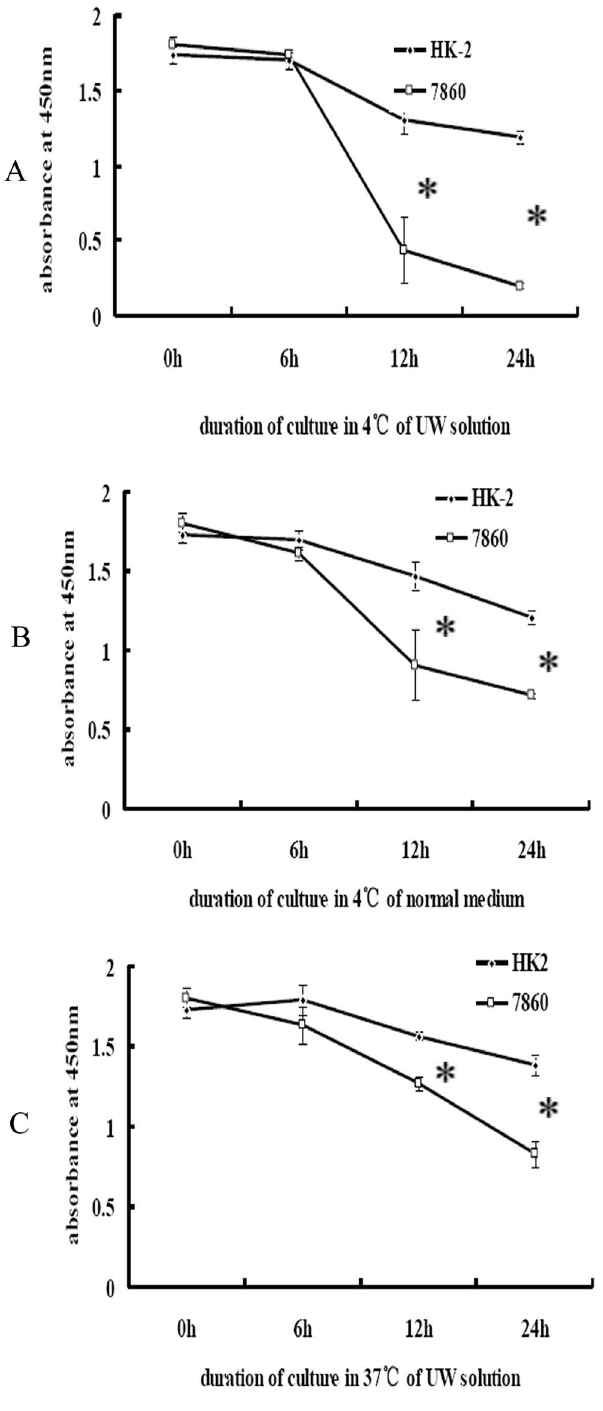
Figure 1. Cellular proliferation under various experimental conditions. Proliferation of HK-2 and 7860 cells after: A, cold-culture (4 u C) in UW solution; B, cold-culture in normal medium; and C, culture at 37 u C in UW solution. Cells were plated onto 96-well plates at 3000 cells per well in complete medium and cultured for 24 h in a 37 u C, 5% CO 2 incubator. The culture medium was then changed, and wells were divided equally into four groups. Groups 1, 2, 3, and 4 were cold- cultured in UW solution for 0, 6, 12, and 24 h, respectively, as indicated. Subsequently, 10 m l of CCK solution was added to each well, and plates were returned to the incubator for 4 h before the absorbance at 450 nm was measured. * p ,